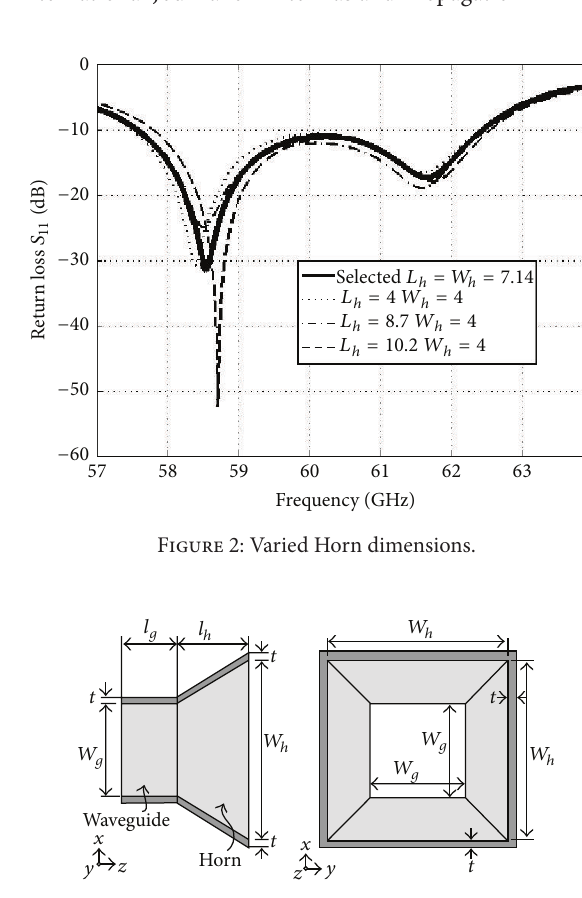
Figure 3: Dimensions of waveguide and pyramidal horn.